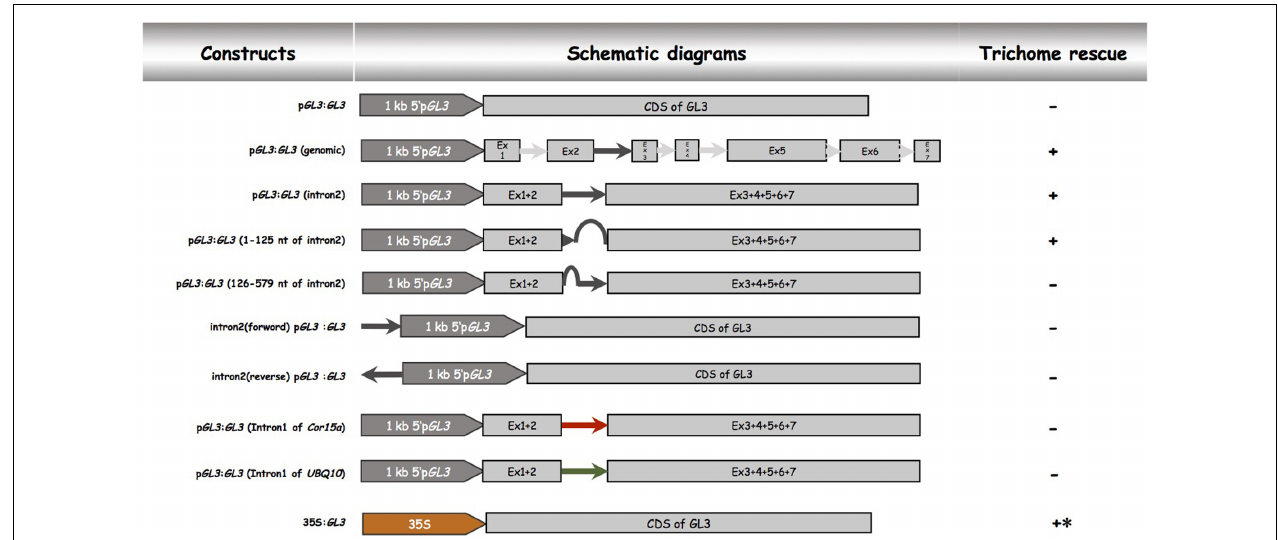
FIGURE 2 | Functional analysis of the second intron of GL3. Schematic description of pGL3 driven genomic GL3 constructs. All constructs were cloned into the pAMPAT vector backbone. Promoter, exon, and intron elements are proportional to the respective sequence length. + indicates trichome rescue of the gl3 egl3 double mutant, – indicates no rescue, ∗ indicates irregular trichome pattern.